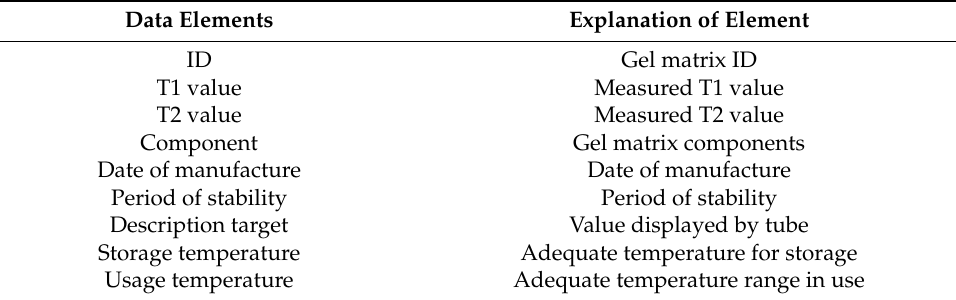
Table 5. Gel matrix data model elements and